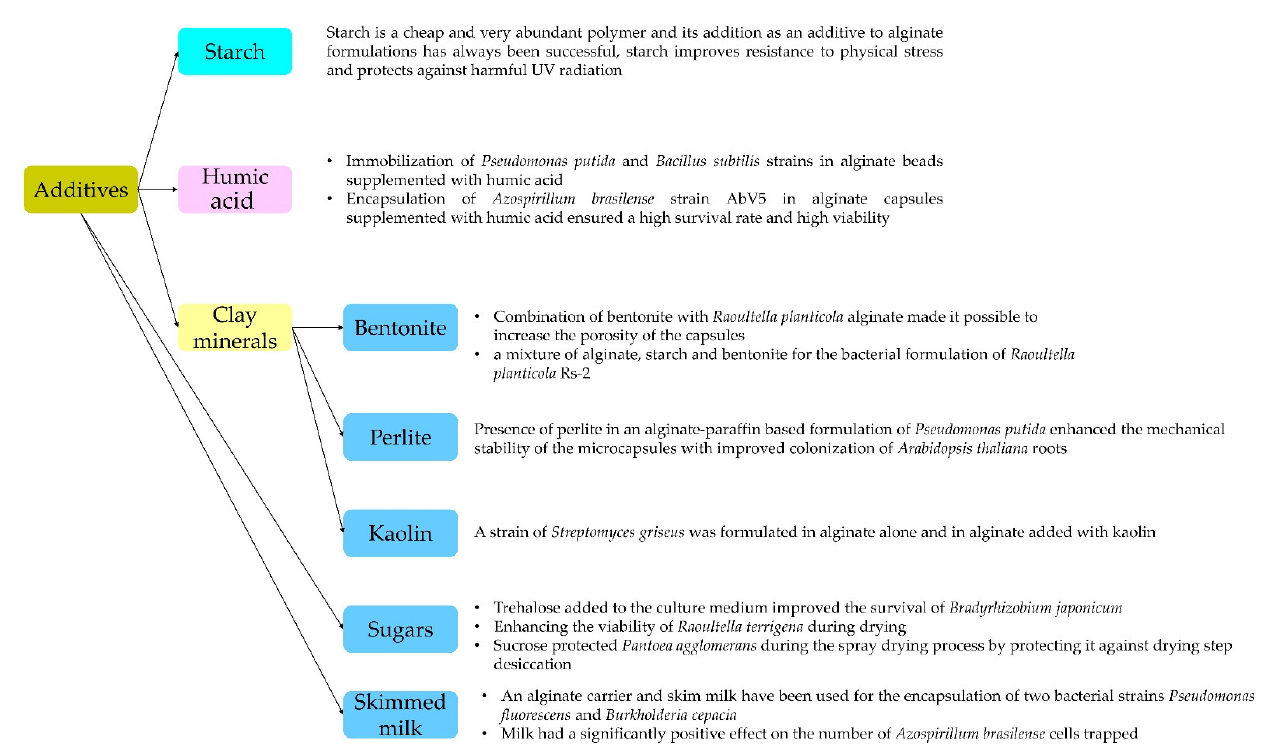
Figure 4. Additives used in the process of encapsulation of PGPMs.